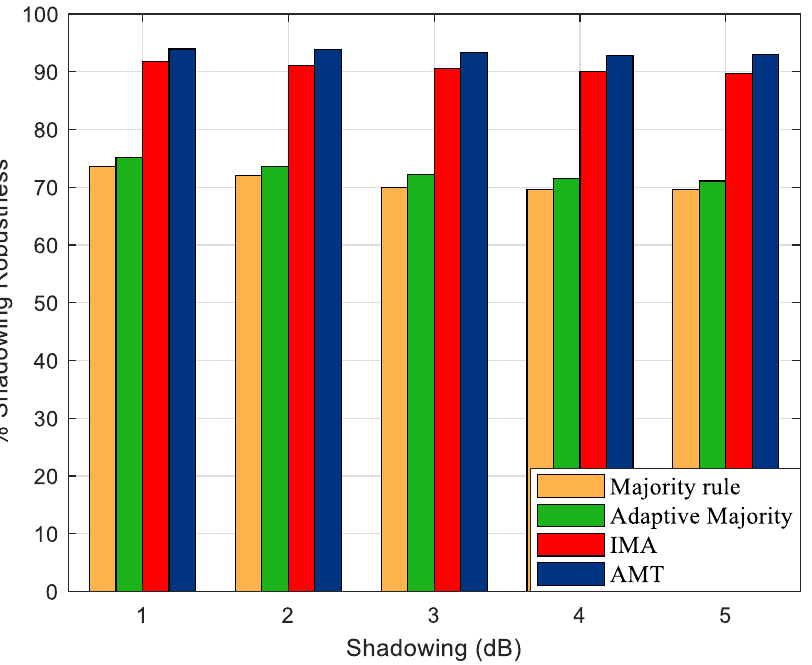
Figure 6. Comparison of the percentage of shadowing robustness at 250 m. From the simulation results, by taking the reliability of SUs into account, the adaptive majority rule, IMA and AMT algorithm improve the detection performance of the